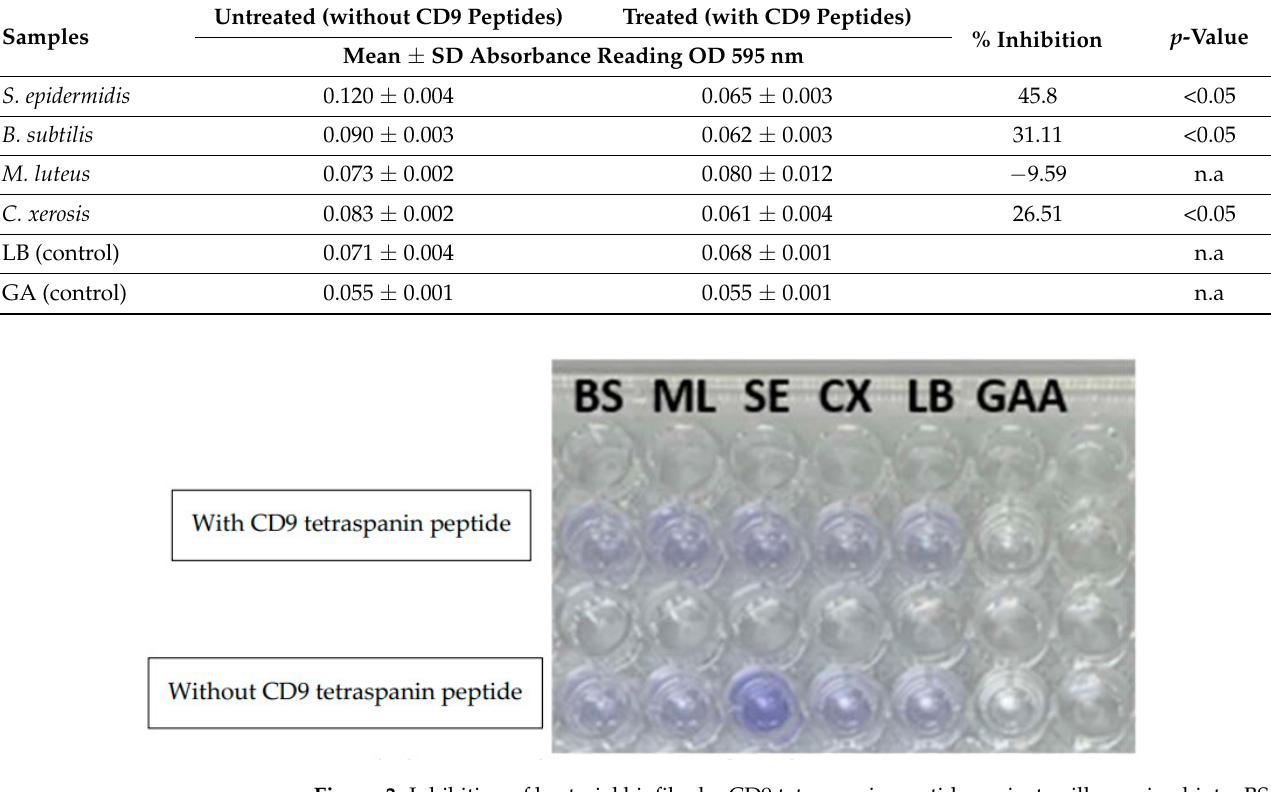
Table 3. Biofilm formation of axillary microbiota with and without D9 tetraspanin peptides.